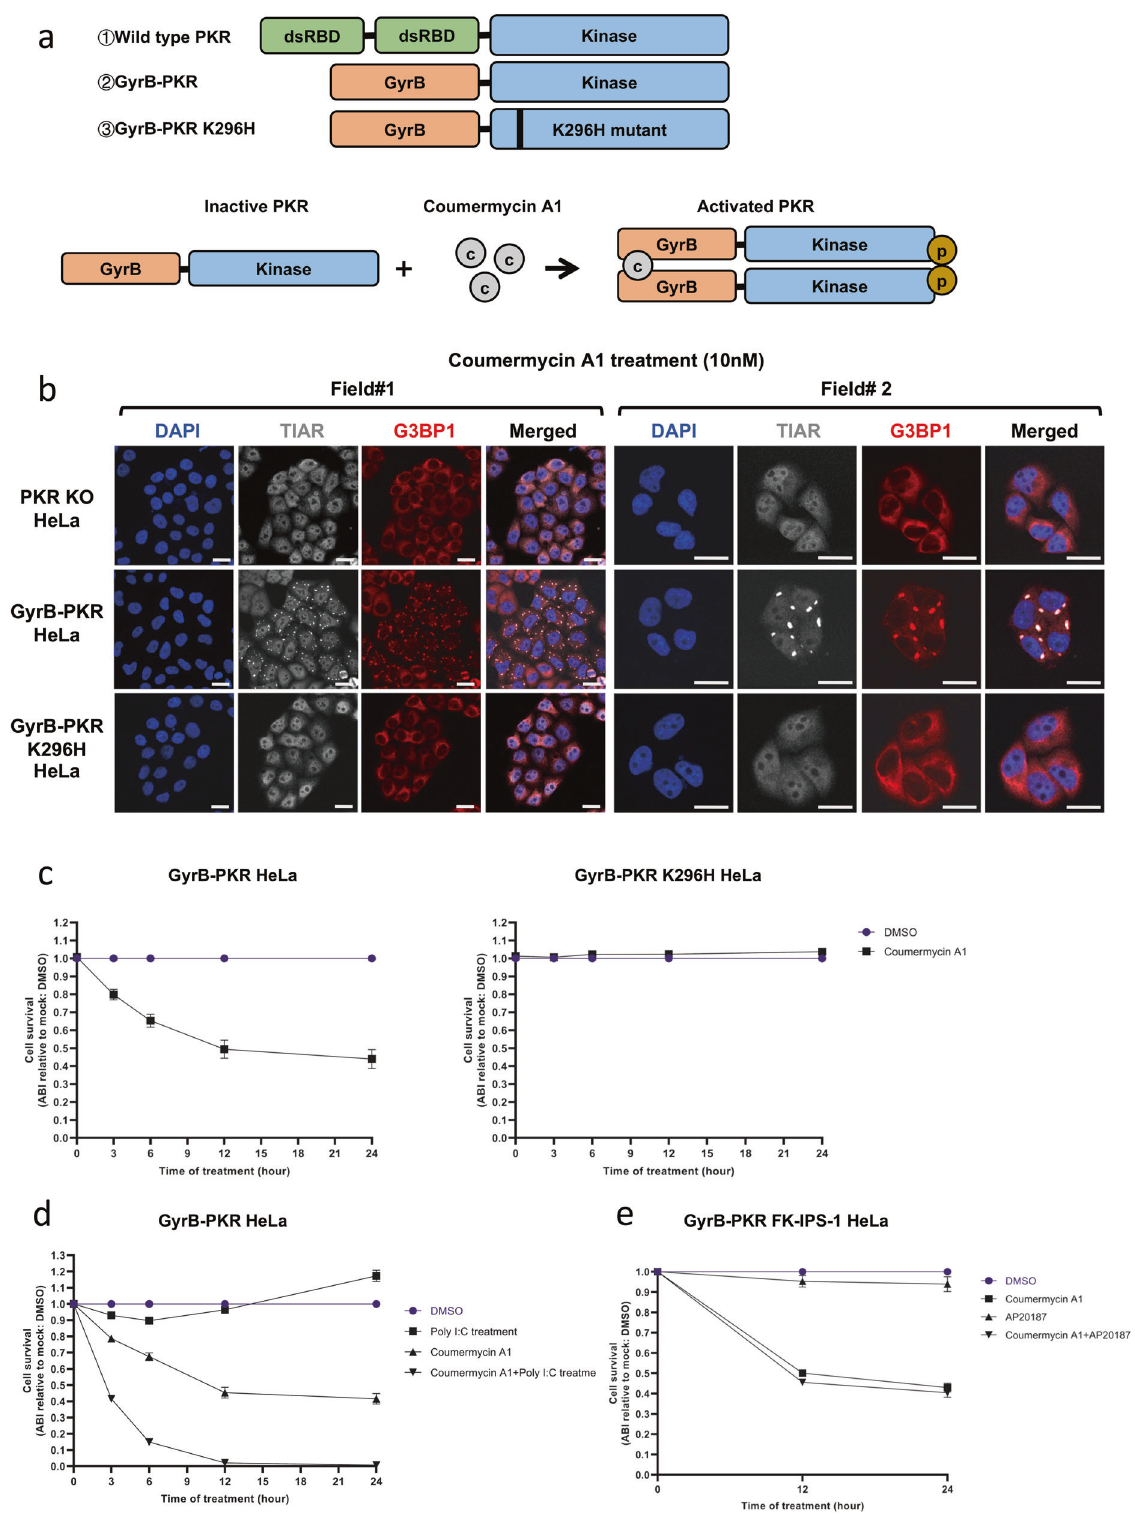
Fig. 4 Synergistic induction of cell death by PKR and the exogenous poly I:C treatment. a Schematic representation of PKR and GyrB-PKR fusion proteins and the activation mechanism of GyrB-PKR fusion by coumermycin A1. b Induction of SG by the coumermycin A1 treatment. PKR KO HeLa, GyrB-PKR HeLa, and GyrB-PKR K296H HeLa cells were treated with coumermycin A1 (10 nM for 3 h) and observed for the SG marker TIAR (gray) and G3BP1 (red), as in Fig. 3c. Scale bar = 25 µm. c GyrB-PKR HeLa and GyrB-PKR K296H HeLa cells were mock treated (DMSO) or treated with coumermycin A1 (10 nM) for the indicated times and examined for cell survival. d GyrB-PKR HeLa cells were treated with the indicated chemicals and examined for cell survival at each time point. e GyrB-PKR FK-IPS-1 HeLa cells were treated with the indicated chemicals and examined for cell survival at each time point. Cell survival in ( c – e ) was examined by the Amido black assay ( “ Materials and methods ” ) and presented as Amido black intensity (ABI) relative to the mock. Data are represented as the means ± SEM of three independent experiments. Cell Death and Disease